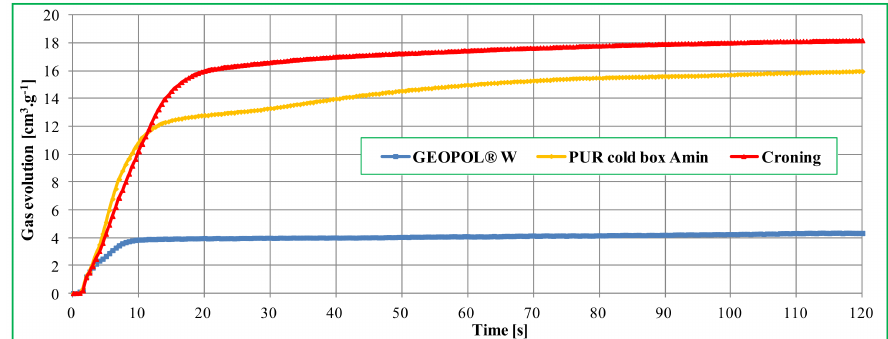
Figure 7. Comparison of gas evolution values of different core mixtures